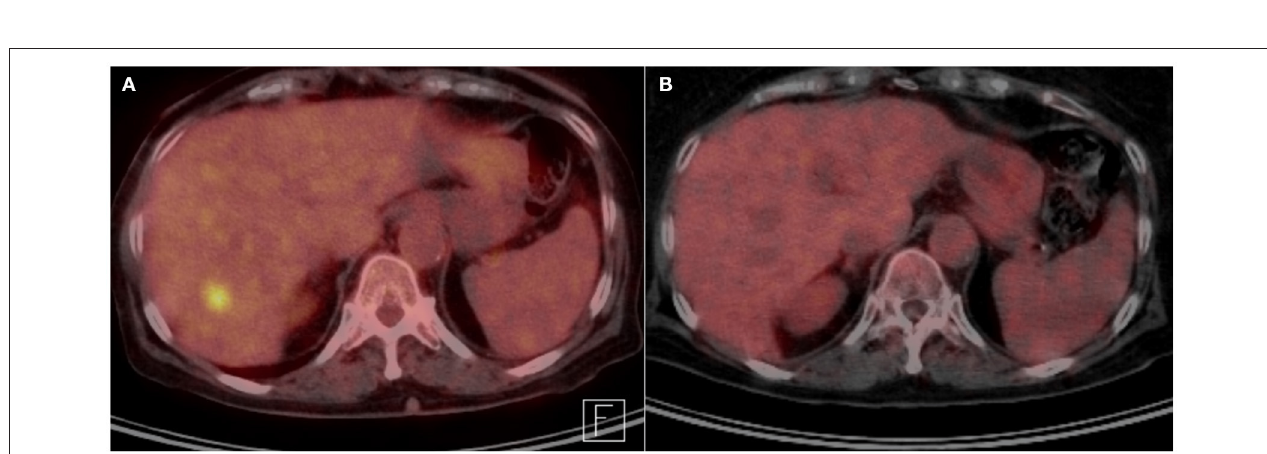
FIGURE 2 | (A) Transverse abdominal PET scan before systemic therapy with TDM1, showing FDG avid liver lesion. (B) Transverse abdominal PET scan after treatment, showing disappearance of FDG avid liver lesion.